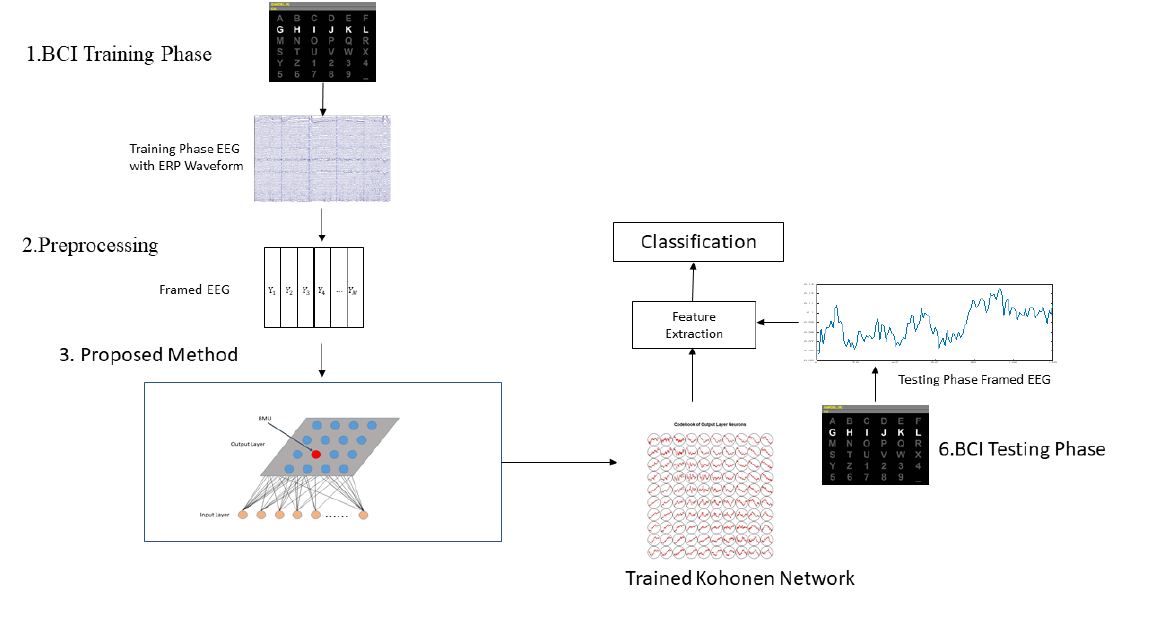
Figure 4. Application Procedures of Proposed Method in